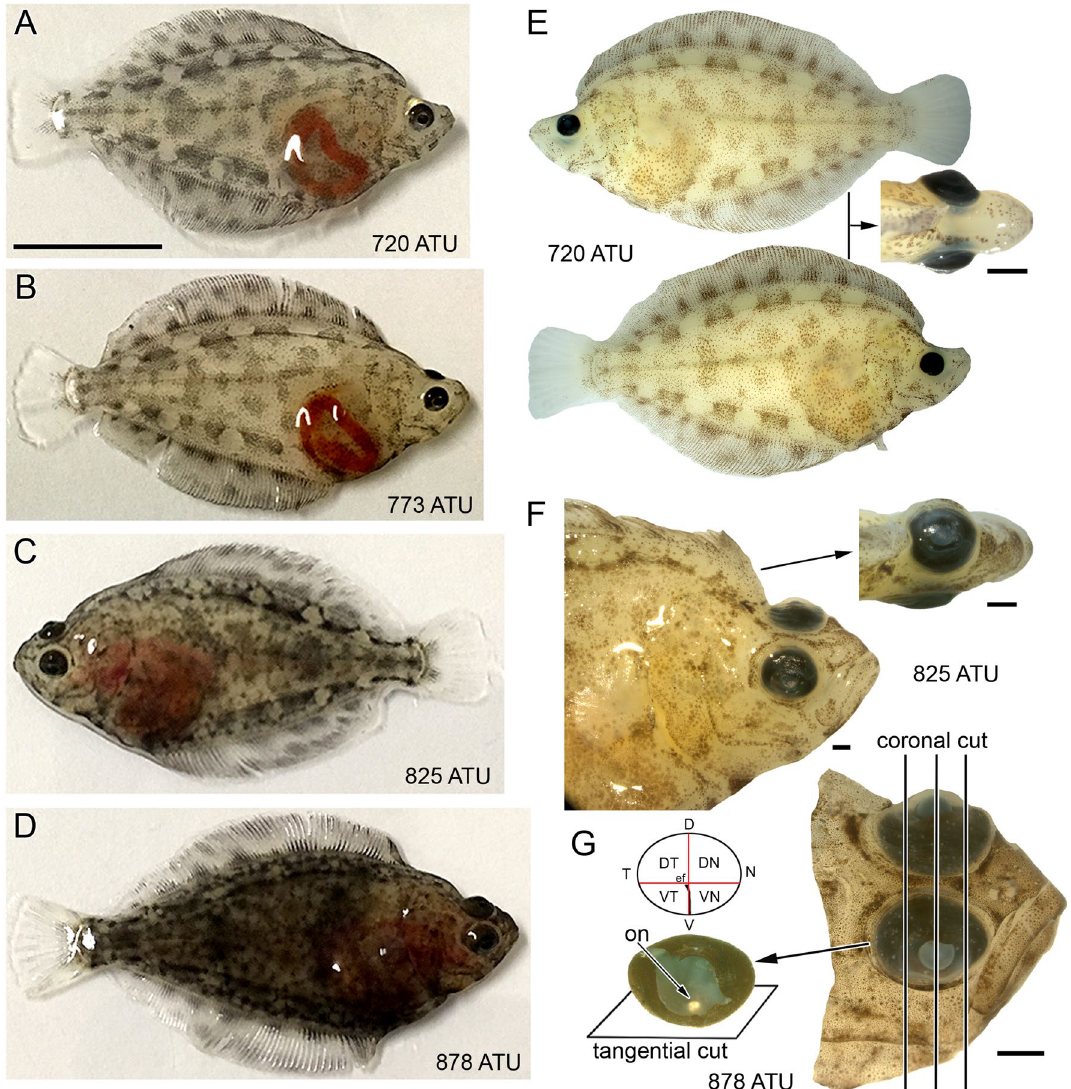
Figure 1. Developmental stages of Atlantic halibut examined illustrating eye migration and orientation of histological sectioning. ( A – D ) Body morphology of live fish at approximately 720 ATU (82 days post- hatching) ( A ), 773 ATU (89 days post-hatching) ( B ), 825 ATU (96 days post-hatching) ( C ), and 878 ATU (103 days post-hatching) ( D ). The left eye is migrating in all fish except for the one shown in ( C ), where the right eye is migrating. ( E ) Lateral and top views of a fixed specimen at 720 ATU. Migration of the left eye has just started. ( F ) Lateral and top views of a fixed specimen at 825 ATU. The left eye has migrated half way between the blind side (bottom part of the fish following metamorphosis) and ocular side (top part of the fish following metamorphosis). ( G ) Head of fixed specimen at 878 ATU showing completed eye migration and the extracted right eye without lens. The optic nerve (on) exits the retina below the crossing of theoretical short and long ellipse axes that characterize this elliptically-shaped eye and retina. The optic nerve head coincides with the central end of the embryonic fissure (ef) which extends to the ventral periphery. The panel illustrates the direction of sectioning when full eyes were cut, revealing tangential sections of central retina and more oblique sections toward the periphery, and coronal cuts when a head was sectioned, revealing radial views of the retina throughout the lens region and tangential views at the nasal and temporal ends. The schematic shows the division of a right eye retina into quarters (VT, ventrotemporal; VN, ventronasal; DT, dorsotemporal; DN, dorsonasal). Other abbreviations: V, ventral; D, dorsal; N, nasal; T temporal. Scale bar in (A) equals 1 cm and holds for ( B – D ) and the lateral views in ( E ); the other scale bars represent 1 mm and are associated with the figures closest to